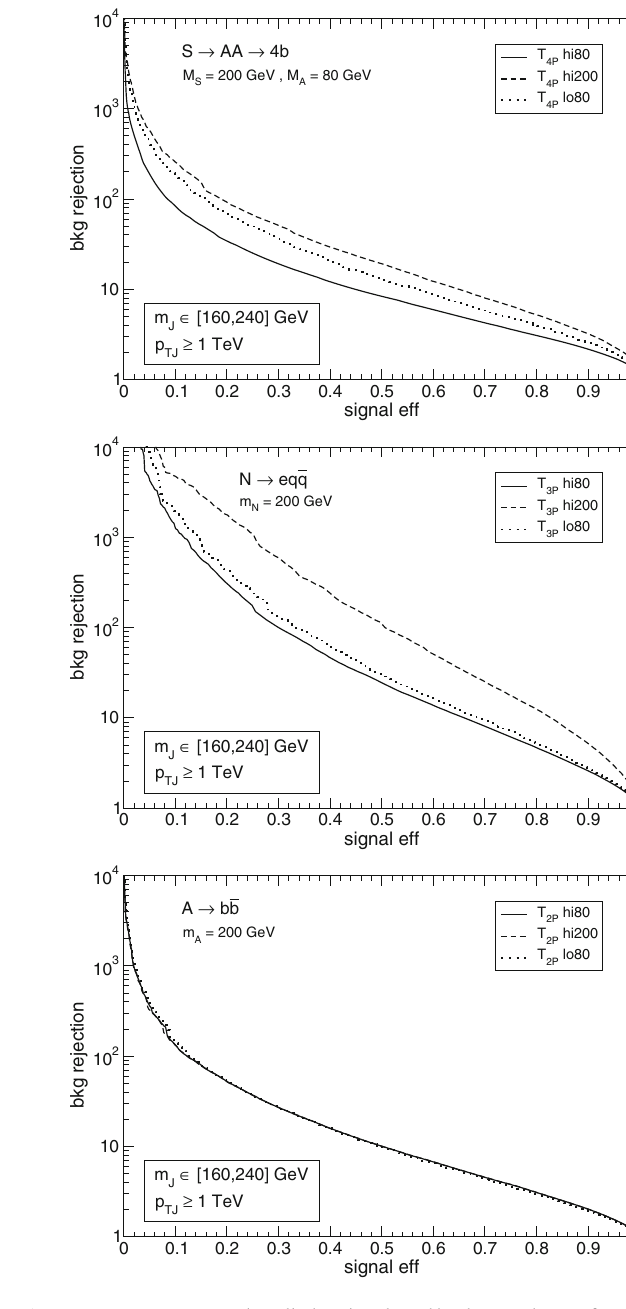
Fig. 6 Comparisonoftaggersdesignedondifferentkinematicalregions( hi80 , hi200 , lo80 andappliedtosignalsandbackgroundsonreference m J and p T J